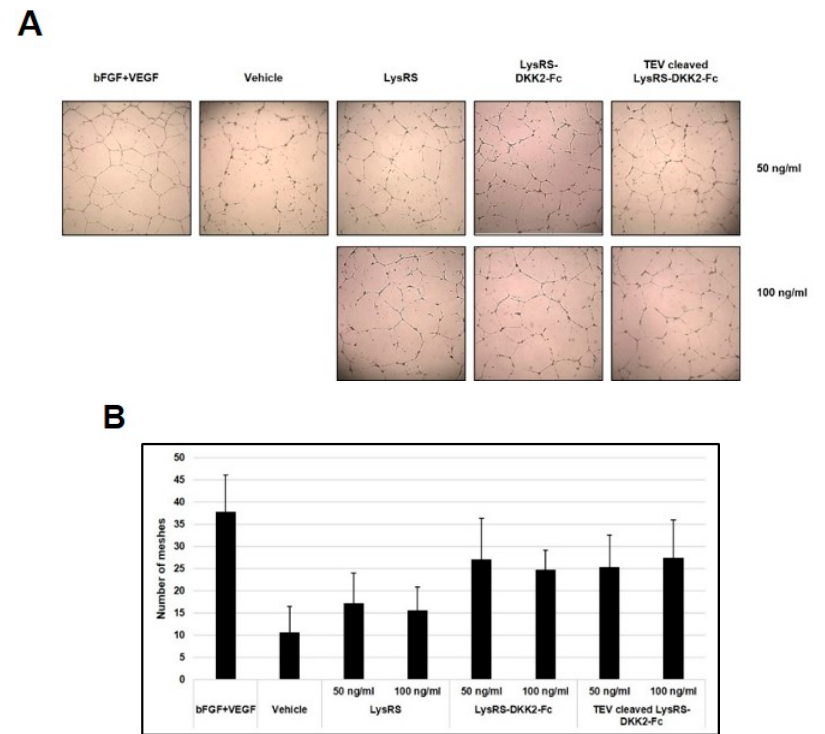
Figure 5. E ff ect of recombinant DKK2-Fc on the formation of EC tube-like structures. ( A ) Tube formation assay using HUVECs. HUVECs were incubated on Matrigel with 50 or 100 ng / mL recombinant proteins (LysRS, LysRS-DKK2-Fc, or TEV-cleaved LysRS-DKK2-Fc), or with a positive control consisting of a mixture of 20 nM bFGF (75 ng / mL) and 10 nM VEGF (270 ng / mL), for 16 h, and observed microscopically (4 × ). ( B ) Visual counts of the number of branch points were performed independently by three individuals.